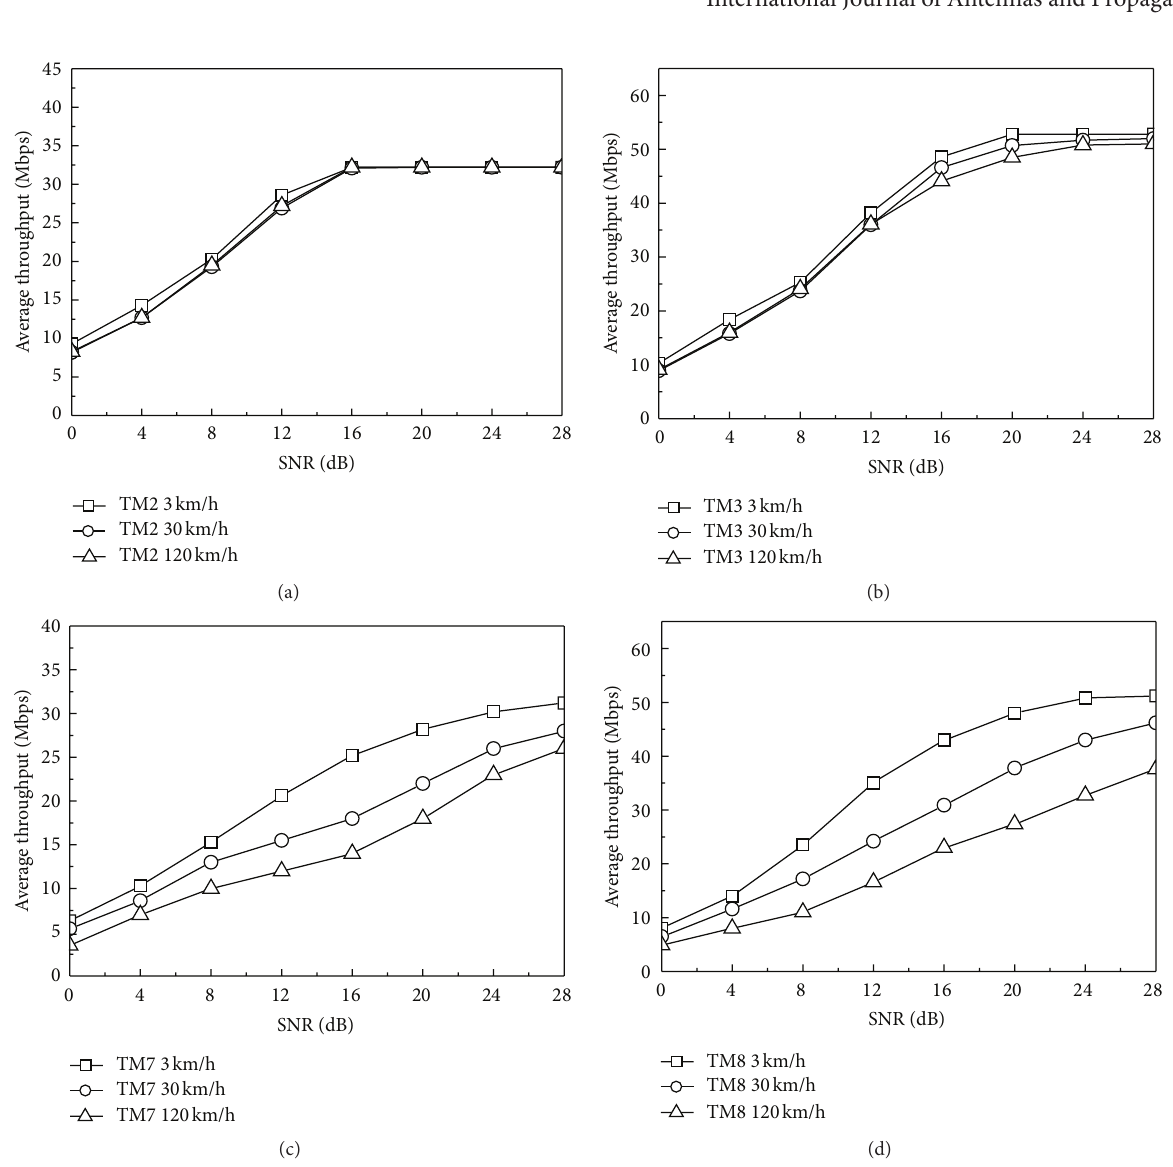
Figure 4: The average throughput for IMT-A based on the indoor